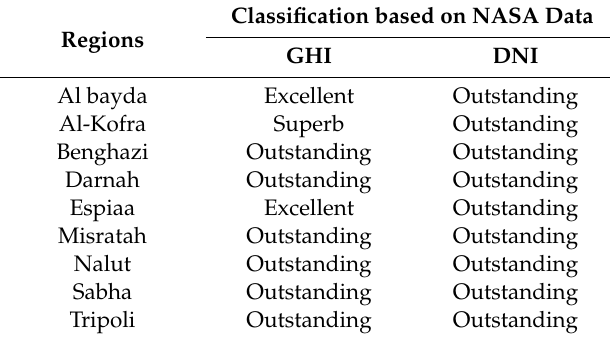
Table 8. Solar potential classification based on annual GHI and DNI [58].